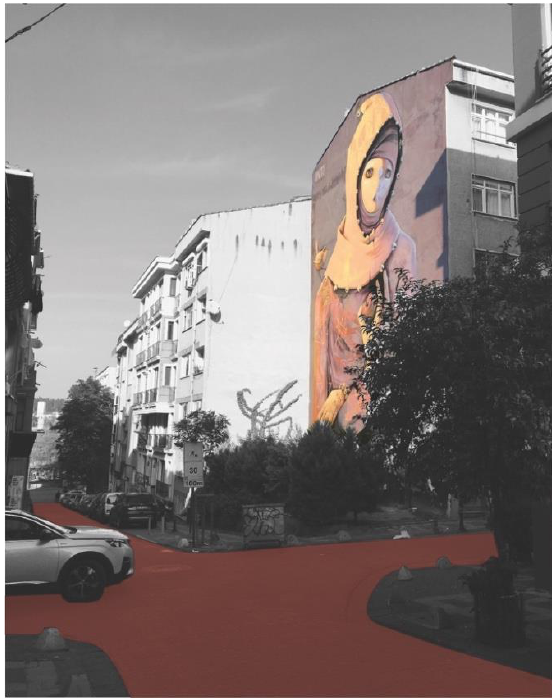
Figure 13 A street junction on which the mural is positioned with high perceptual